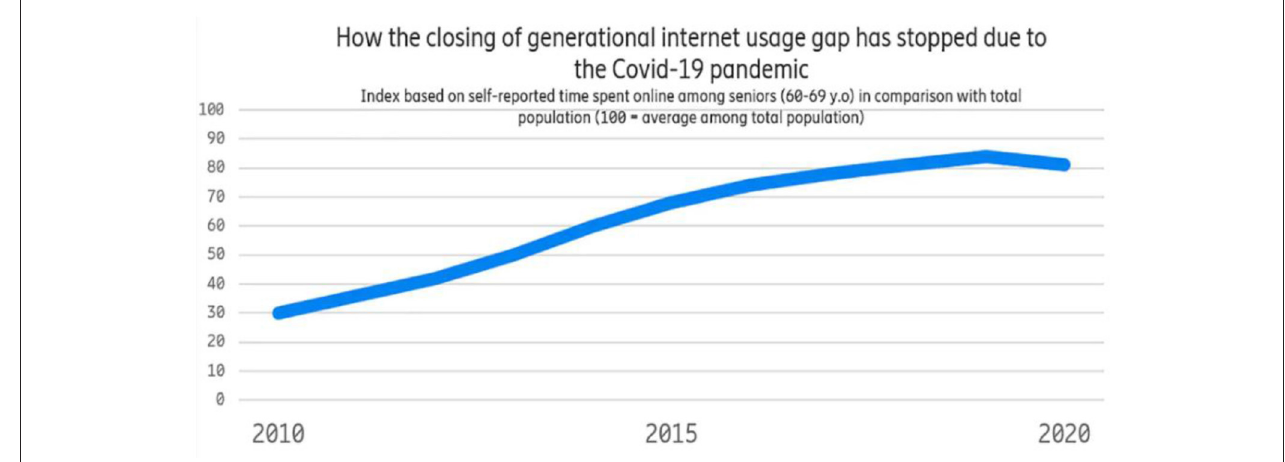
FIGURE 1 | How the internet usage gap has stopped since the outbreak of the pandemic.